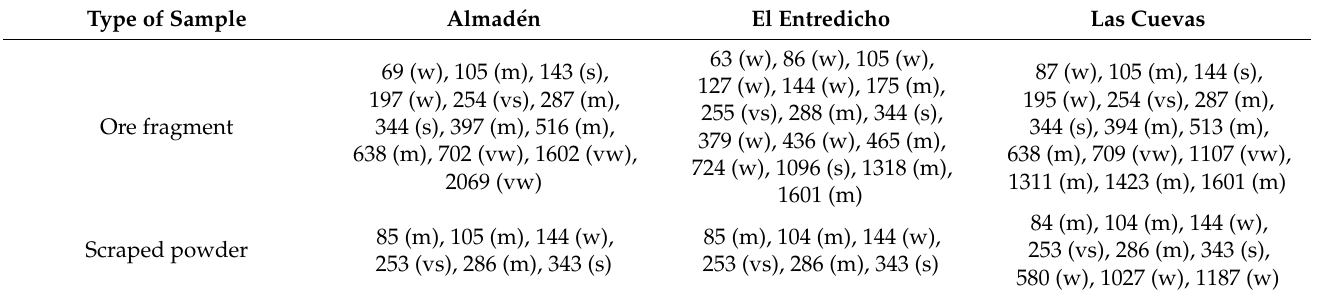
Table 1. Raman bands detected on each mineral ore (Almad é n, El Entredicho, Las Cuevas) using the portable spectrometer.